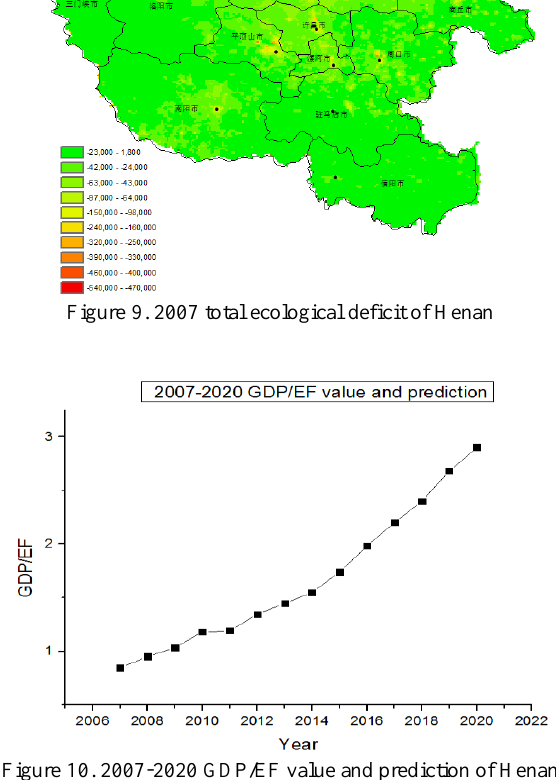
Figure 10. 2007-2020 GDP/EF value and prediction of Henan